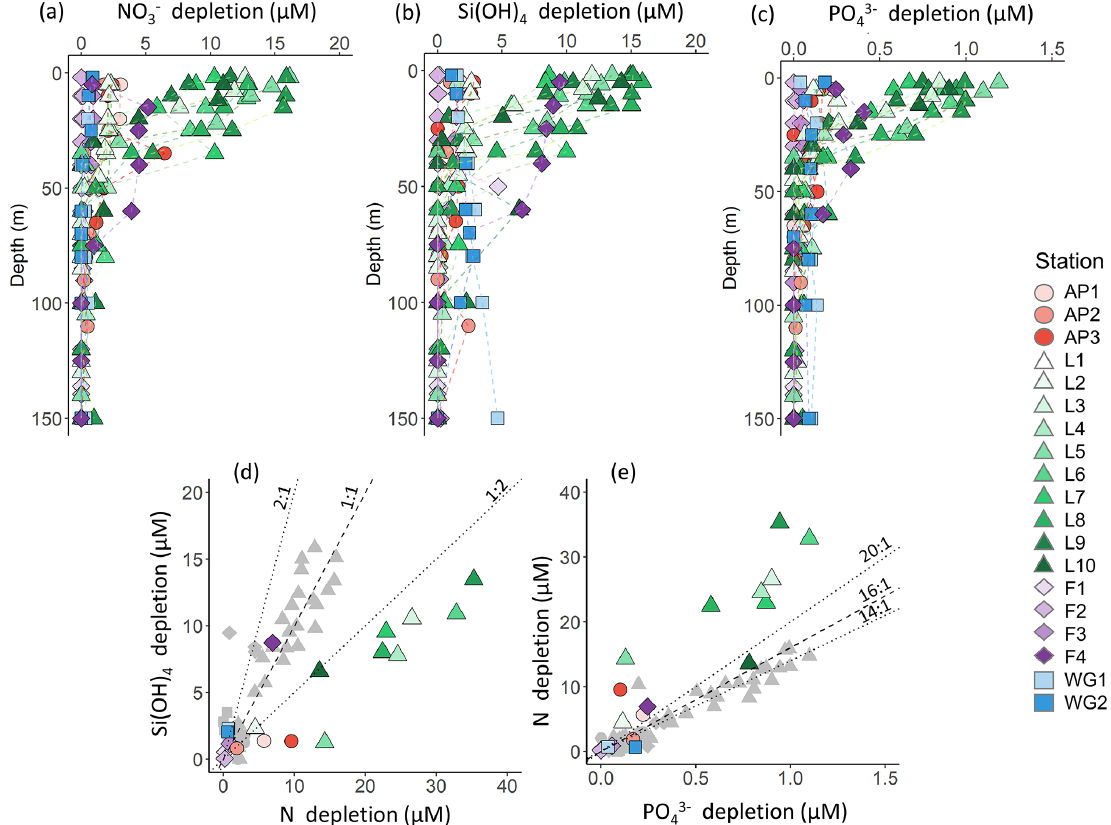
Figure 4. Depth profiles (0–150m) of (a) NO 3 − depletion, (b) Si ( OH ) 4 depletion, and (c) PO 43 − depletion at each station. Also shown are scatterplots of (d) Si ( OH ) 4 depletion versus total N depletion (coloured symbols; see text for details) and Si ( OH ) 4 depletion versus NO 3 − depletion (grey symbols) and (e) PO 43 − depletion versus total N depletion (coloured symbols) and PO 43 − depletion versus NO 3 − depletion (grey symbols) at each station. The dashed line in panel (d) represents the 1 : 1 Si : N depletion ratio, expected for iron-replete diatoms (Ragueneau et al., 2000; Hutchins and Bruland, 1998; Takeda, 1998; Mosseri et al., 2008), while the dotted lines represent the 2 : 1 Si : N ratio, expected for iron-limited diatoms (Arrigo et al., 1999; Franck et al., 2000; Brzezinski et al., 2003; Green and Sambrotto, 2006; Mosseri et al., 2008; Weber and Deutsch, 2010; Martiny et al., 2013), and the 1 : 2 Si : N ratio, indicative of enhanced activity of non-siliceous phytoplankton. The dashed line in panel (e) represents the 16 : 1 N : P depletion ratio (the Redfield ratio), while the dotted lines represent the 20 : 1 N : P ratio, expected for P. antarctica , and the 14 : 1 N : P ratio, expected for iron-replete diatoms (Hutchins and Bruland, 1998; Takeda, 1998; Arrigo et al., 1999; Ragueneau et al., 2000; Mosseri et al.,